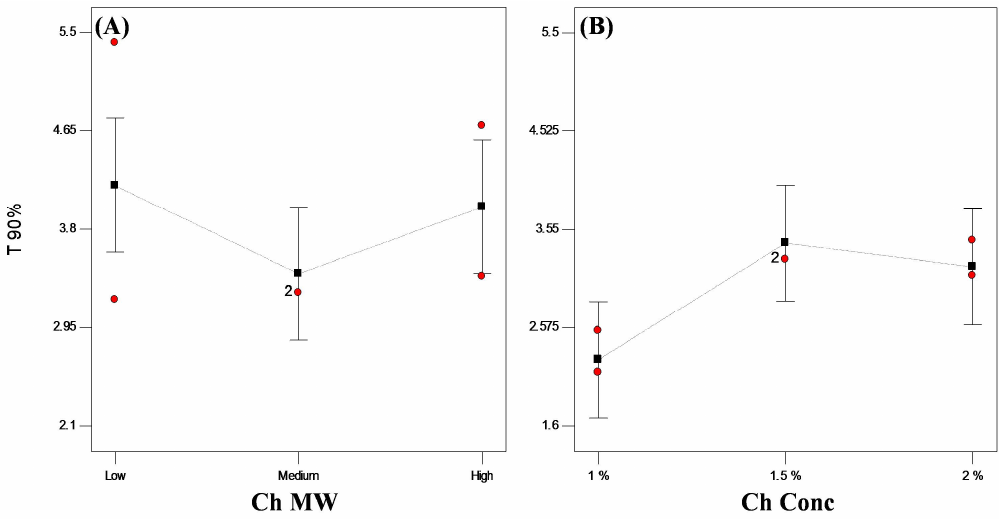
Figure 5. Plot for the main effects of ( A ) Ch MW and ( B ) Ch concentration on t 90% of VP from VP-loaded Ch-based beads.